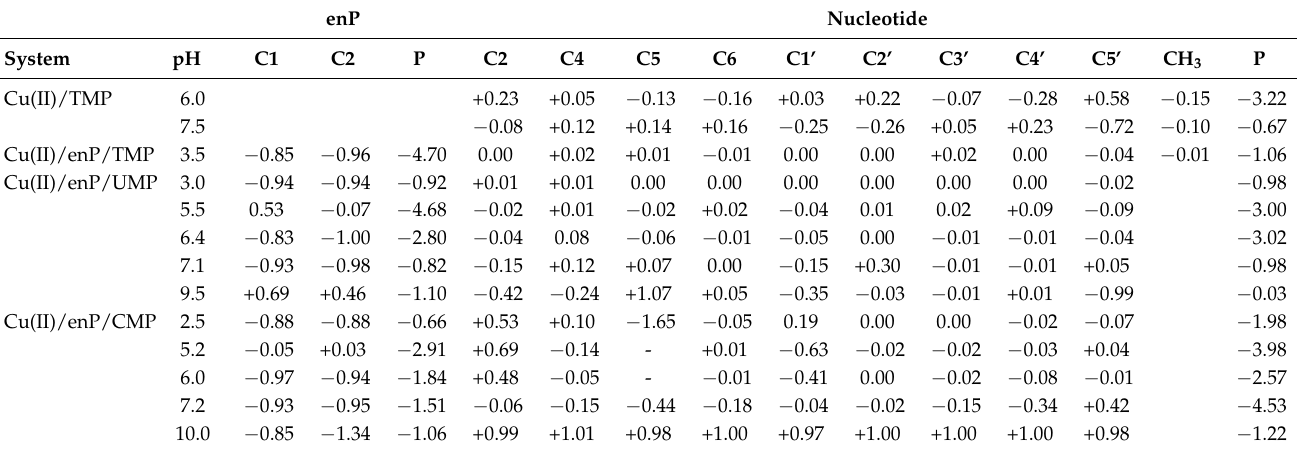
Table 3. NMR differences between signal positions for the ligand in the complex in relation to the free ligand